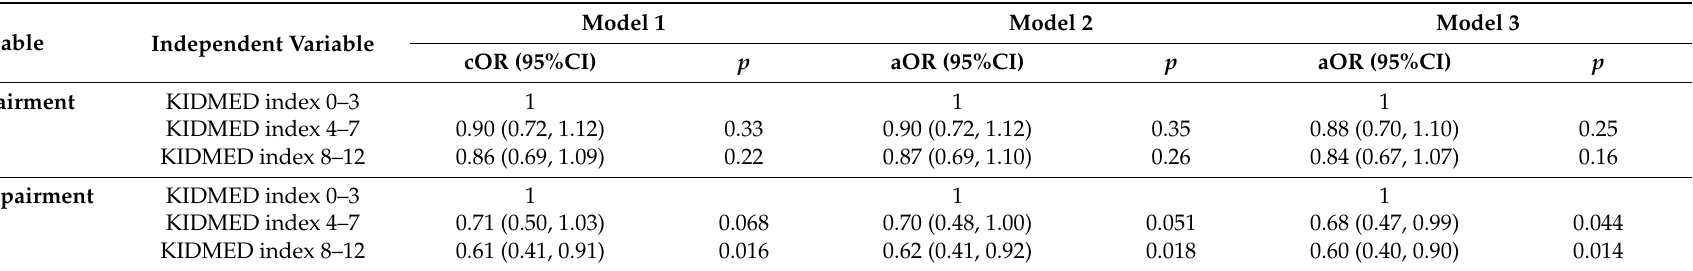
Table 3. Longitudinal associations of kidney impairment with KIDMED index among children aged 6–9 in Beijing, China using generalized linear mixed- effects